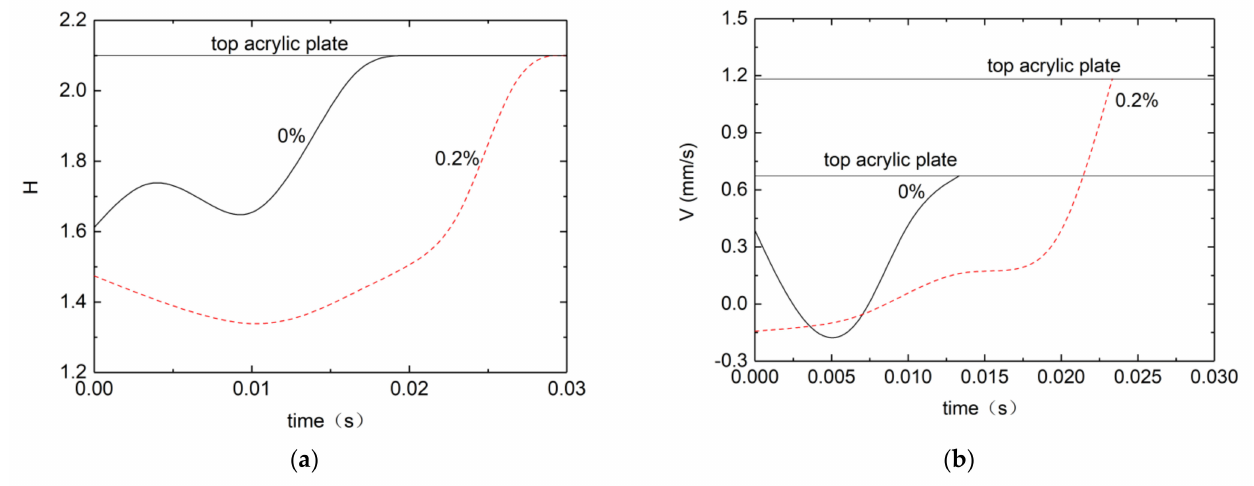
Figure 8. Droplet position and velocity vs. time for Newtonian and viscoelastic droplets. ( a ) Position of the droplet tip. ( b ) Velocity at the droplet tip for water and 0.2% PEO aqueous solution taking off on a superhydrophobic surface (150 ◦